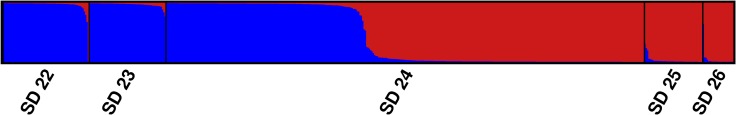
Assignment of Baltic cod (N = 554) inferred from model-based clustering with STRUCTURE at k = 2 using 20 SNP loci.